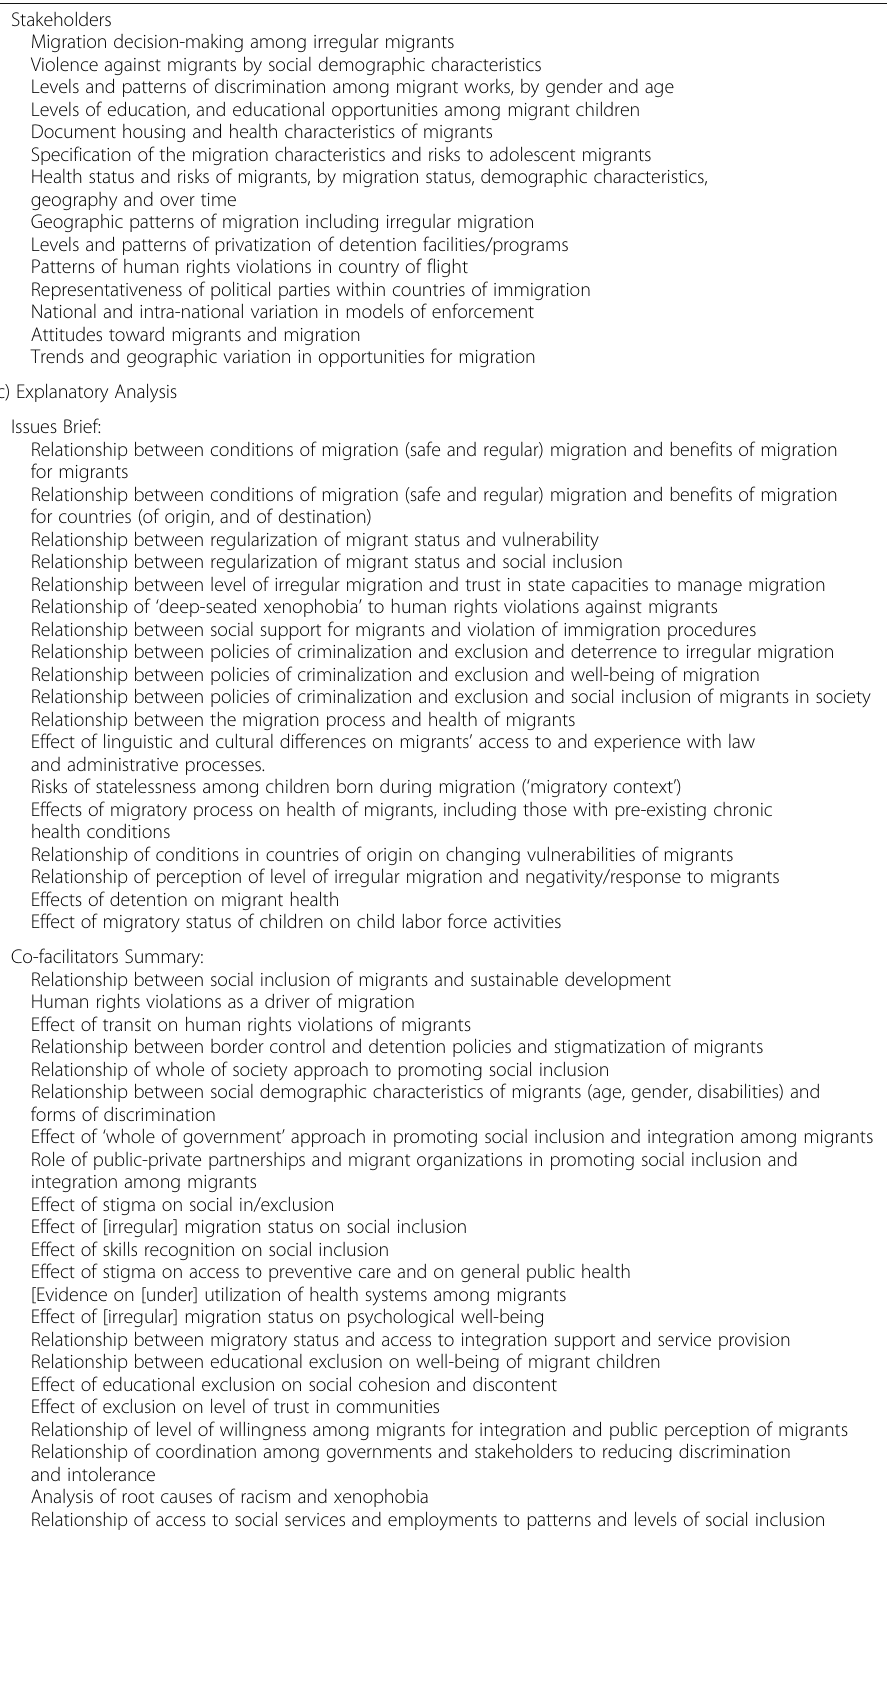
Table 1 Proposals for data and research: Thematic Session I Human rights of all migrants, social inclusion, cohesion and all forms of discrimination, including racism, xenophobia and intolerance